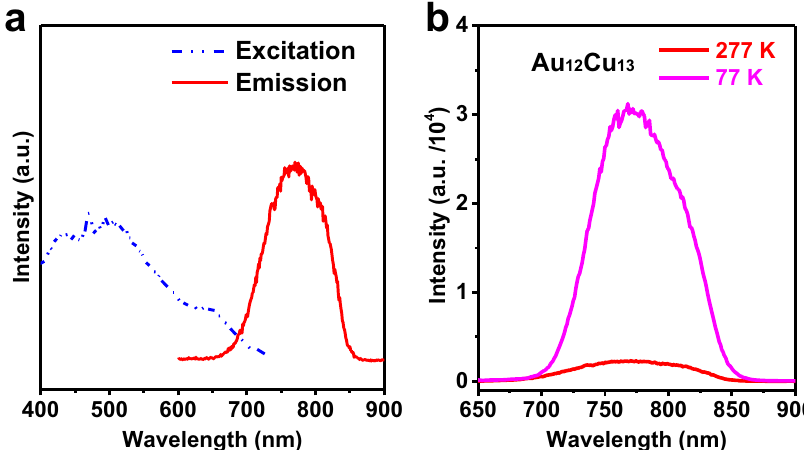
Fig. 5 Fluorescence property of Au 12 Cu 13 clusters. a Excitation and emission spectra of Au 12 Cu 13 cluster in solution. b Temperature-dependent fl uorescence of Au 12 Cu 13 clusters in